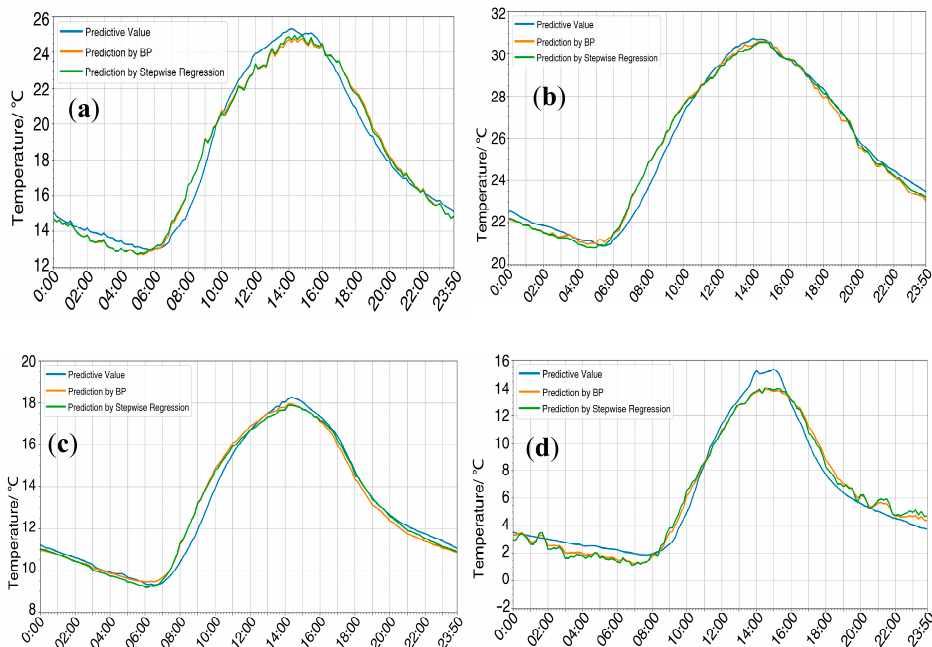
Figure 5. The daily variation trend of the measured and predicted temperature in the greenhouse for Bailing mushroom. ( a ) spring ( b ) summer ( c ) autumn ( d ) winter.